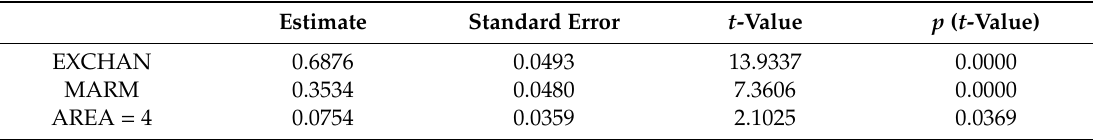
Table A5. Regression coe ffi cients for the model of the field prices of mandarins without considering the time (MONTH) or variety (VAR) variables.